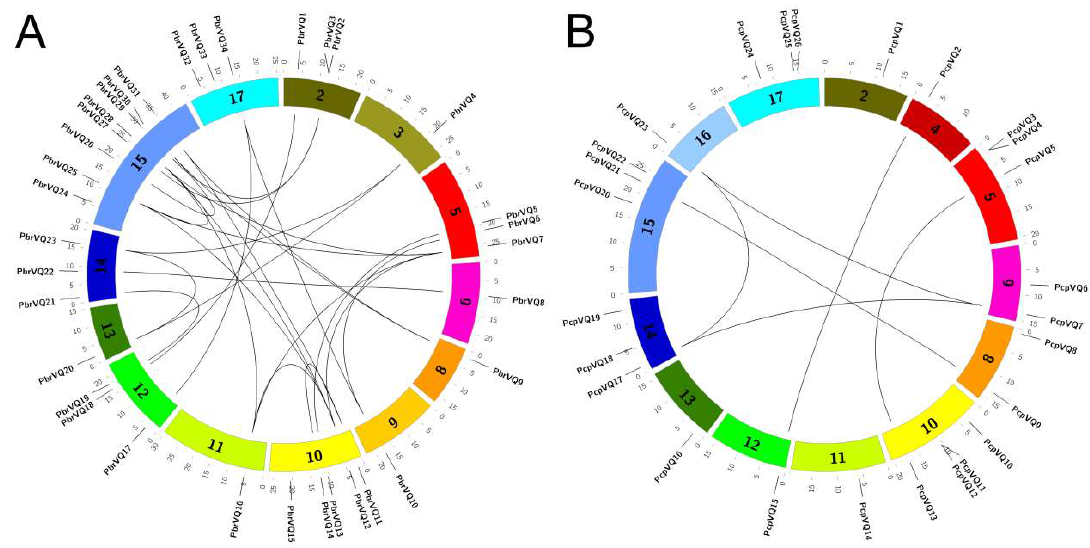
Figure 3. Chromosome location and duplication events analysis in both P. bretschneideri ( A ) and P. communis ( B ) VQ motif-containing genes. The outermost scale represents the megabases (Mb). The location of each VQ motif-containing genes is marked with a grey line using Circos software. The duplication gene pairs were linked by black lines. Remarkably, because PbrVQ35 , PbrVQ36 , PbrVQ37 , PbrVQ38 , PbrVQ39 , PbrVQ40 , PbrVQ41 , PcpVQ27, and PcpVQ28 were located on the scaffold, the location of these genes is not shown in Figure 3.